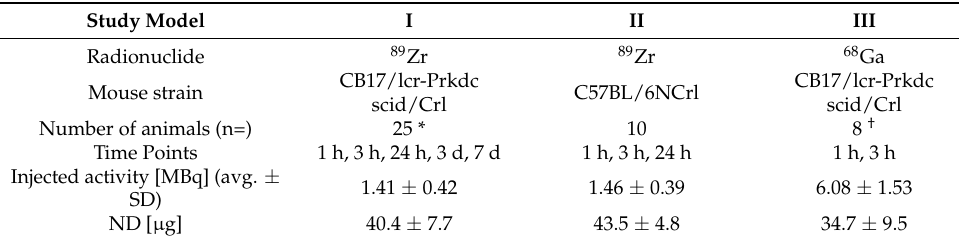
Table 1. Overview of the experiments performed with details of the respective radionuclide, number of animals, and injected mass [ µ g] and injected activity ([MBq], mean and standard deviation (SD)). Study